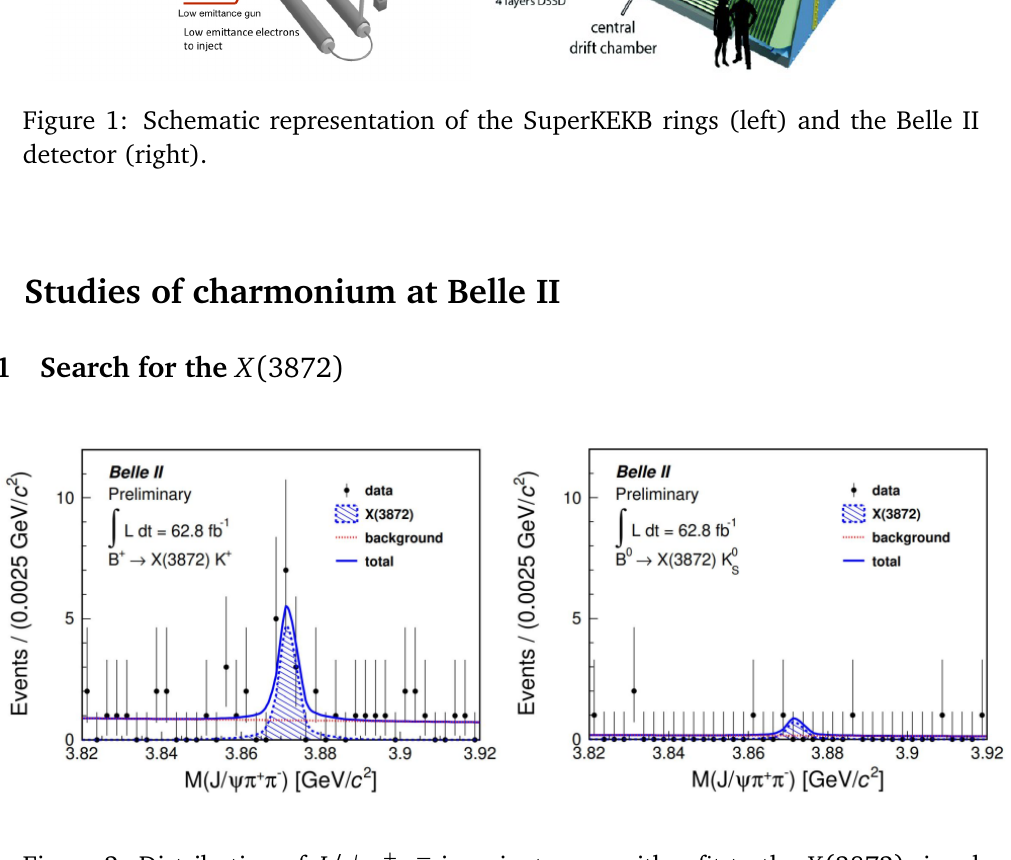
Figure 2: Distribution of J /ψπ + π − invariant mass with a fit to the X ( 3872 ) signal superimposed for the charged (left) and the neutral (right) B